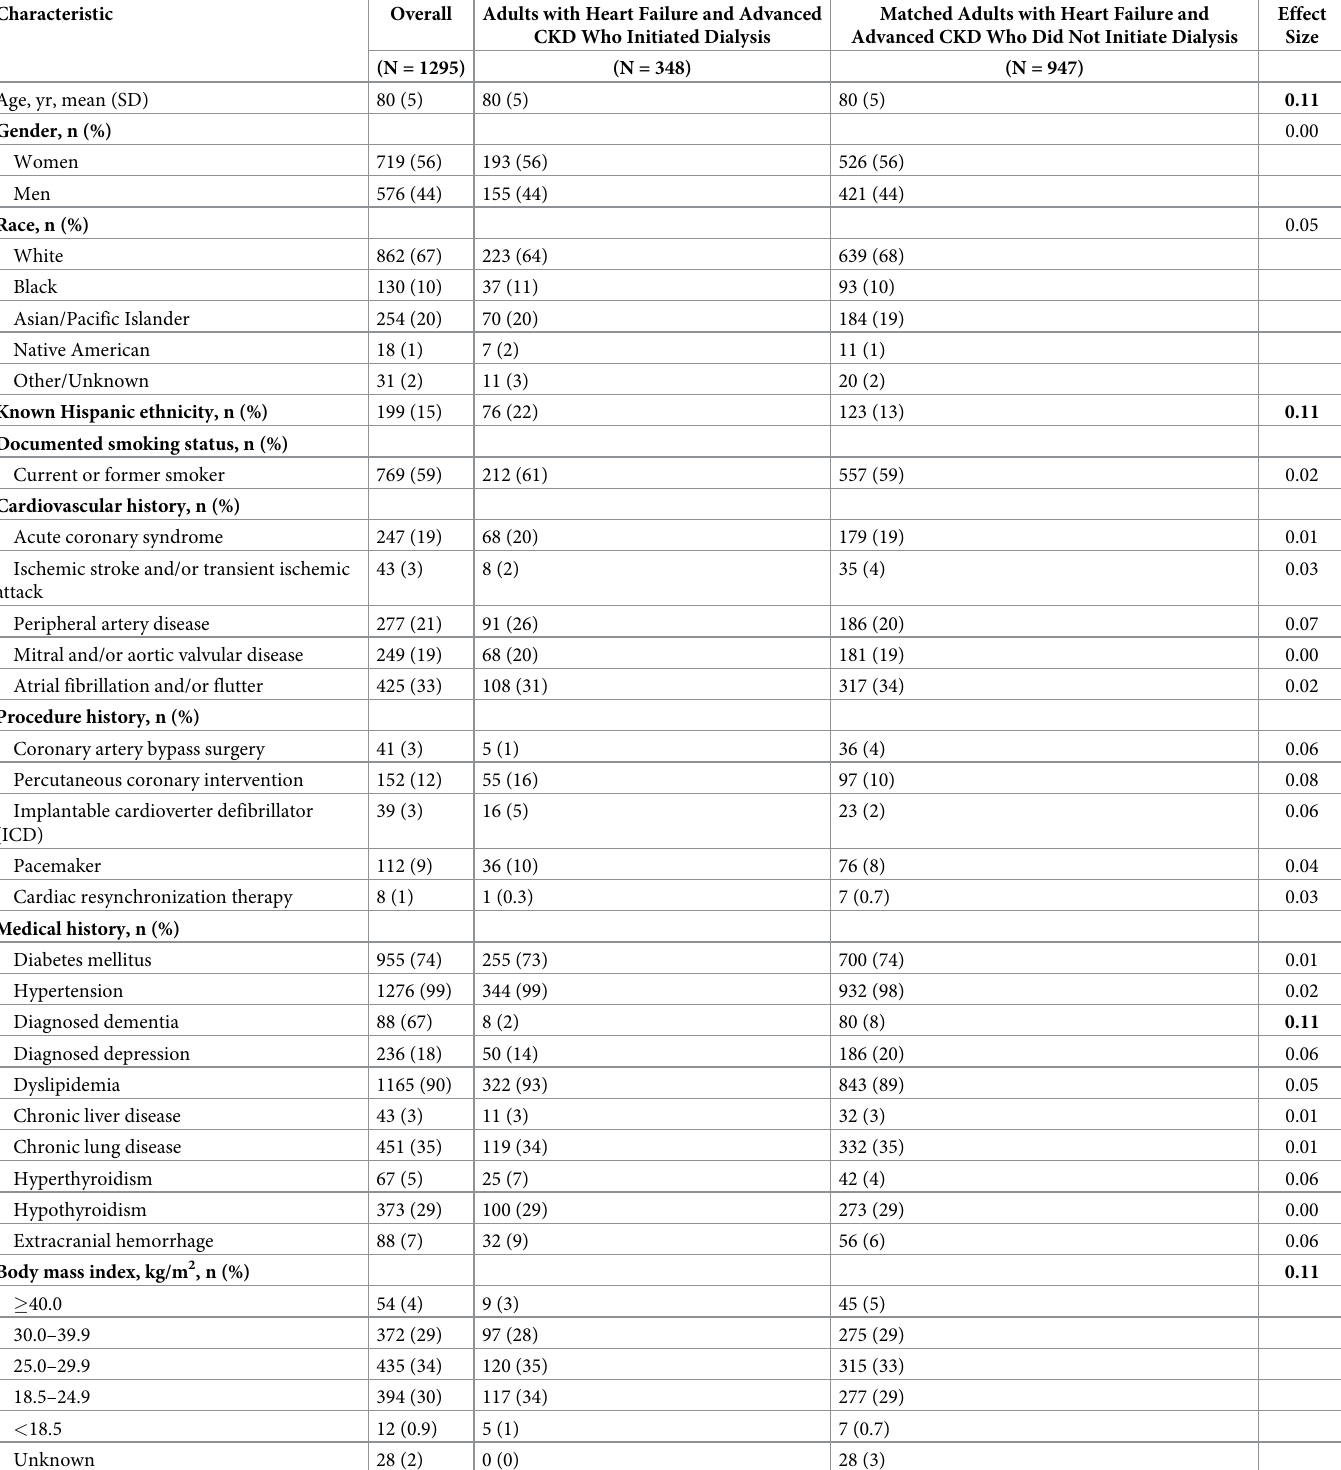
Characteristic Overall Adults with Heart Failure and Advanced